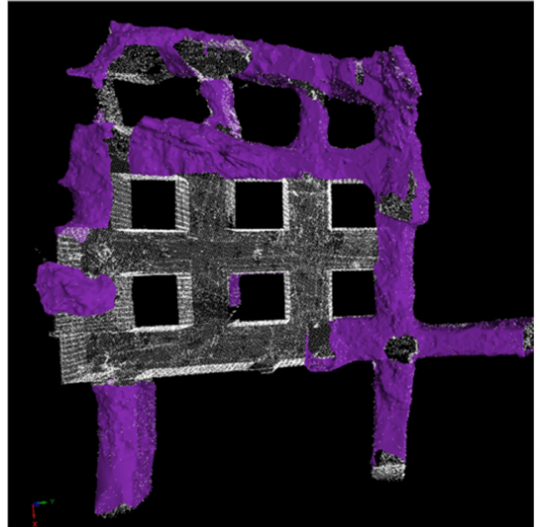
Figure 14. Detail mesh (in purple) of the underground portions where the rock mass is